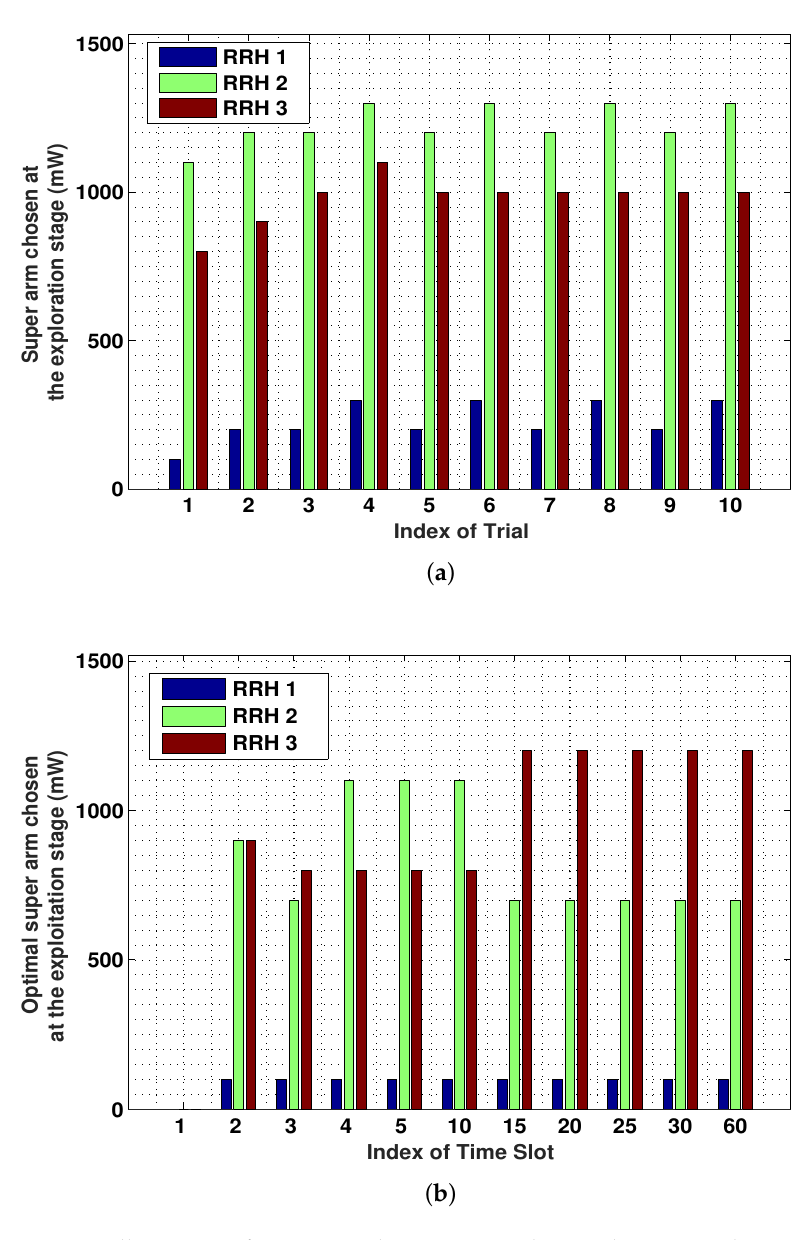
Figure 4. Illustration of super arm decisions according to the proposed strategy: ( a ) super arms chosen in the individual trials at the fifth time slot; ( b ) look-ahead energy purchase decisions (i.e., final super arm) for individual time